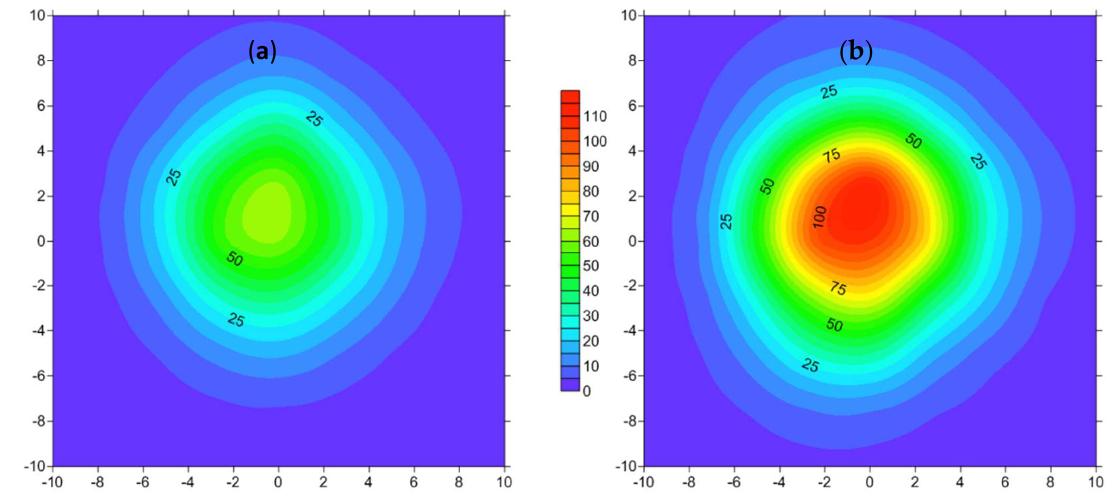
Figure 17. Irradiance [W/cm 2 ] reached with all lamps switched on; ( a ) 40% of power (1600 W); ( b ) 80% of power (3600 W); the coordinates are expressed in cm from the center of the workbench; the colormap scale is referred to both graphs.